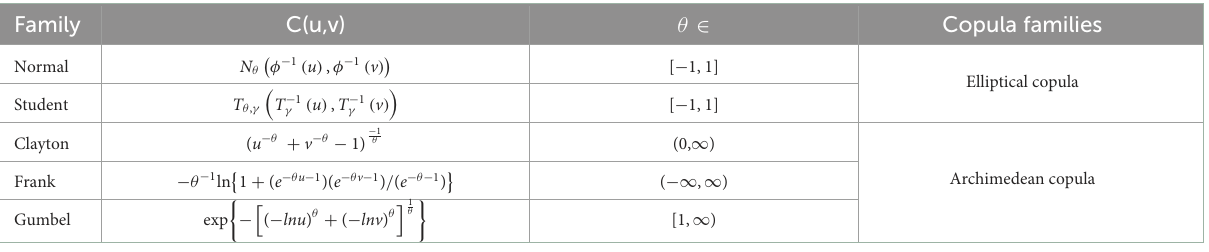
TABLE 3 Descriptive statistics for monthly minimum, maximum temperature (unit: ◦ C), and rainfall (mm) from 1961 to 2015. Variables Minimum temperature